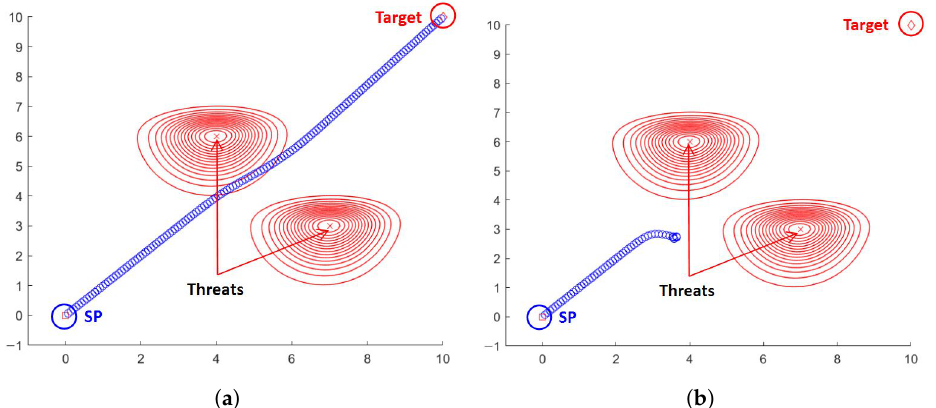
Figure 9. Effect on the path planning of choice of δ k : ( a ) result when δ k is large ( δ k = 2); ( b ) result when δ k is small ( δ k = 0.01). Table 2. The suggested range of δ k that was empirically obtained. Size of